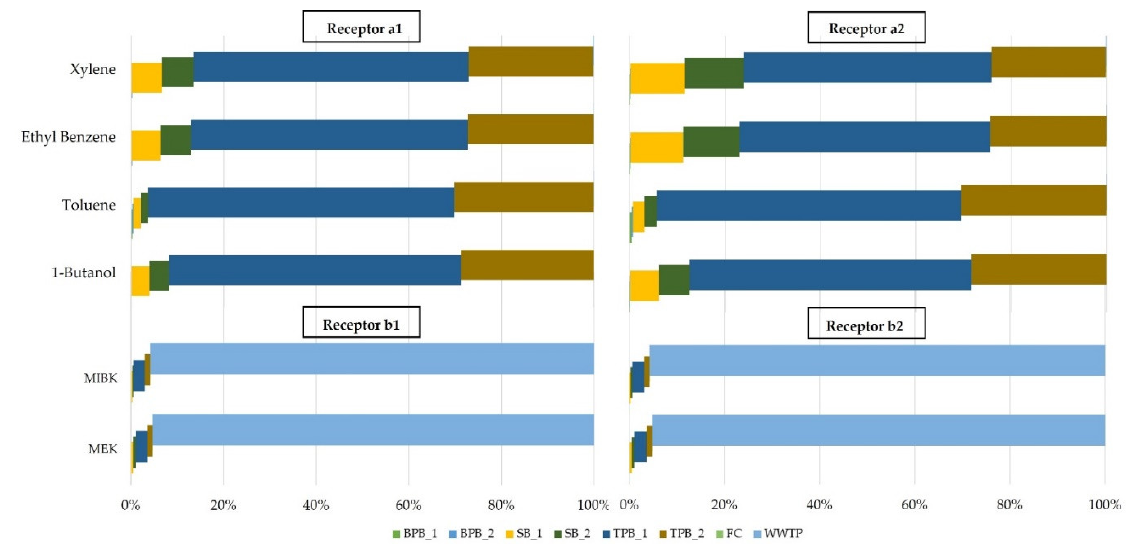
Figure 6. Source identification of each substance at receptors.